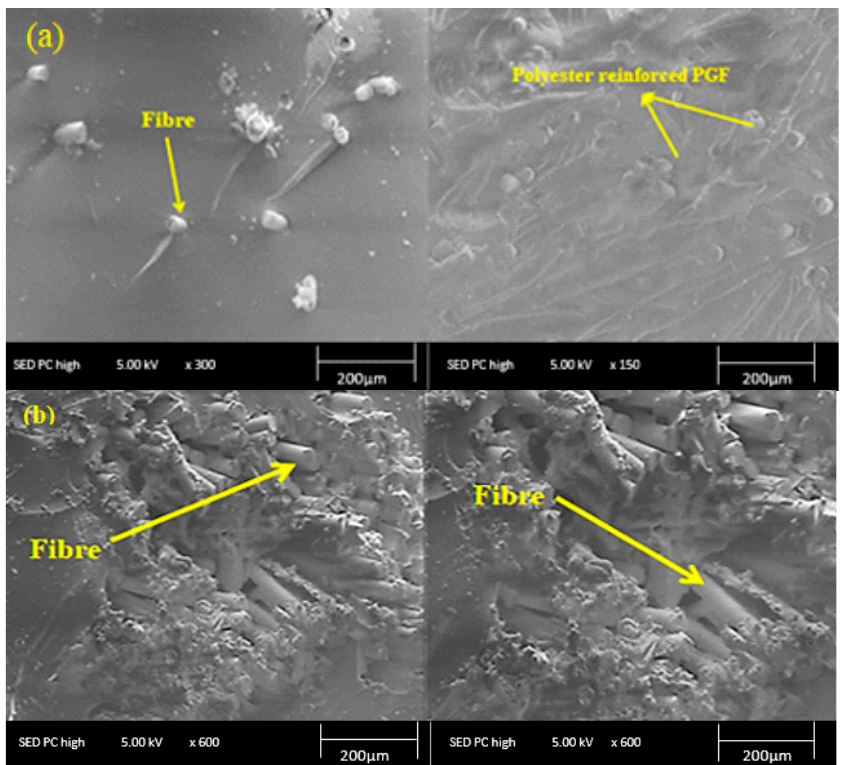
Figure 7. Morphology of polyester composites reinforced with 16 wt % of PGF ( a ) and 20 wt % of PGF ( b ).